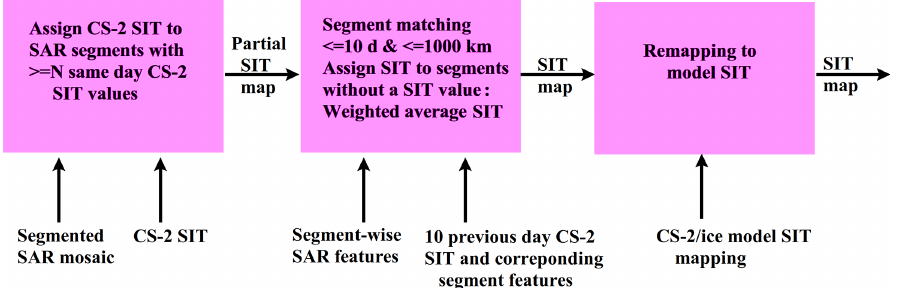
Figure 6. Algorithm block diagram for the sea ice thickness estimation using combination of the CryoSat-2 sea ice thickness data and Sentinel-1 SAR imagery. We have used N = 7 in this